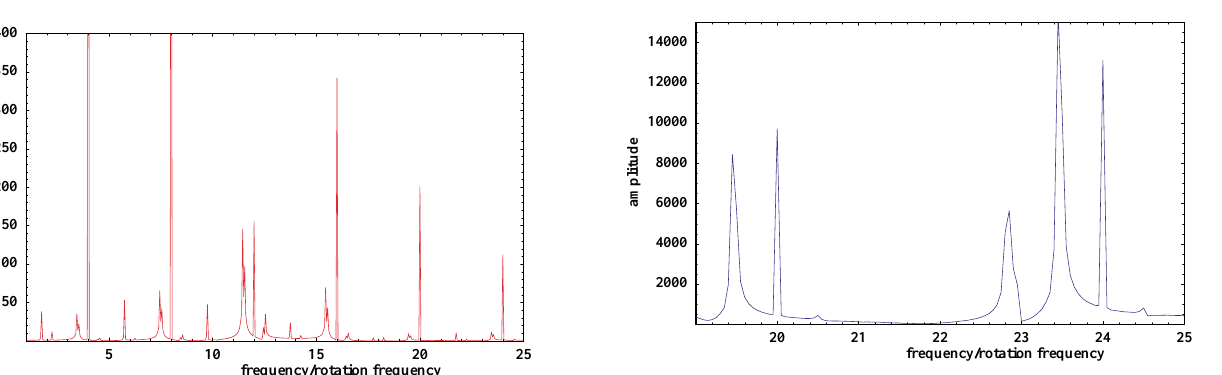
FIG. 25. (Color) Spectrum of (cid:5) x 2 (cid:6) after 250 turns. of (cid:5) x (cid:6) . For the frequencies of envelope oscillations (cid:5) x 2 (cid:6) , we have